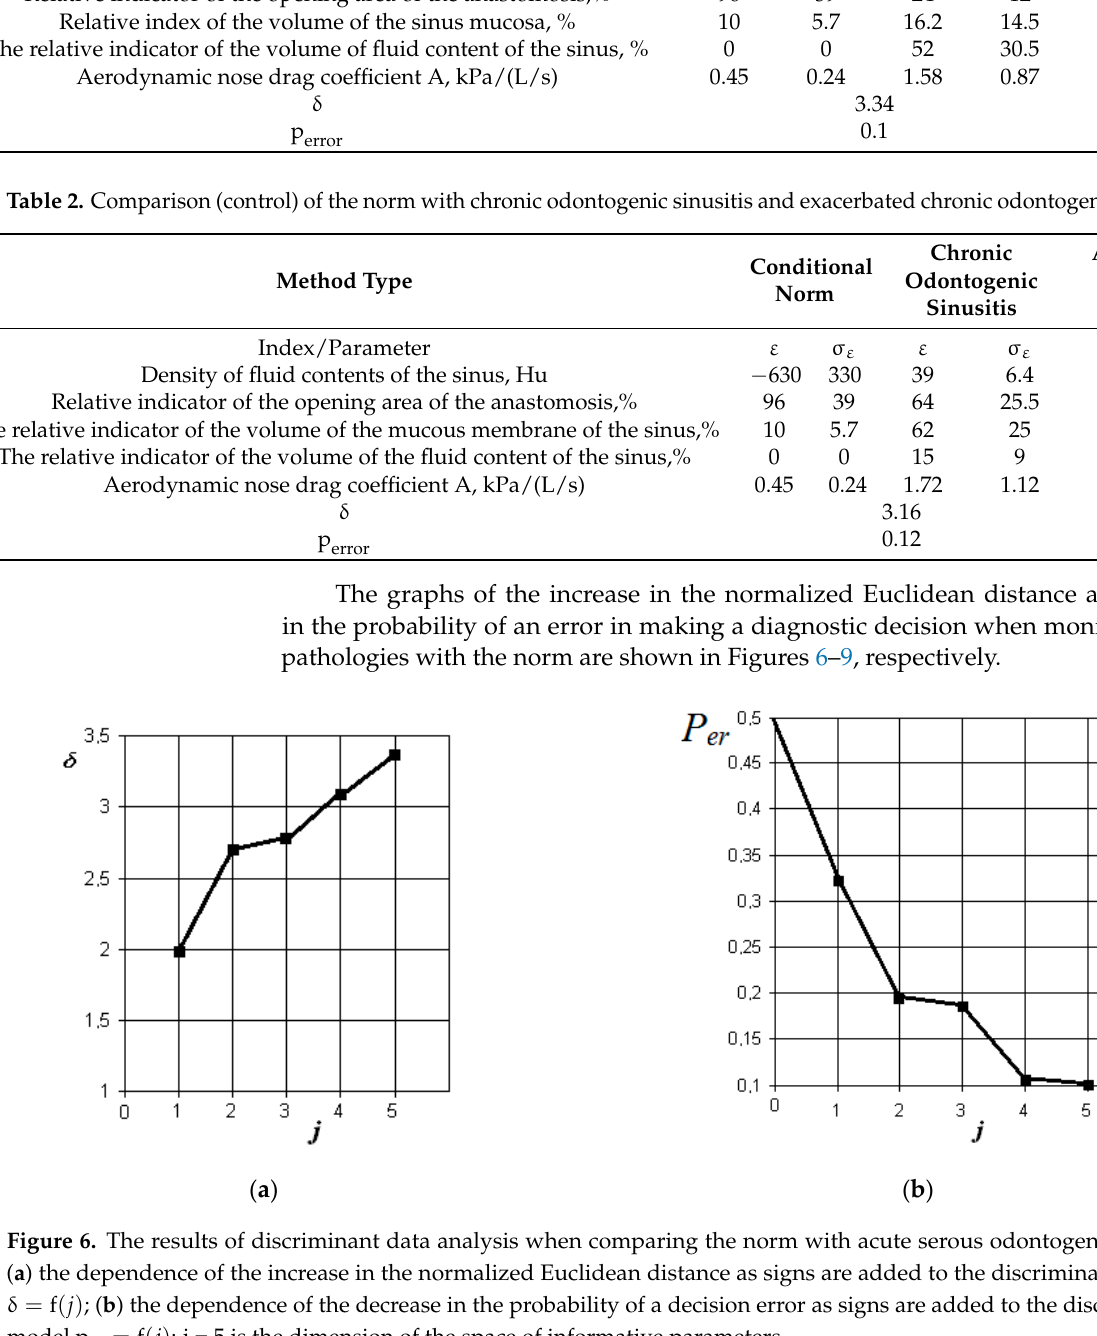
Acute Serous Conditional Odontogenic Norm